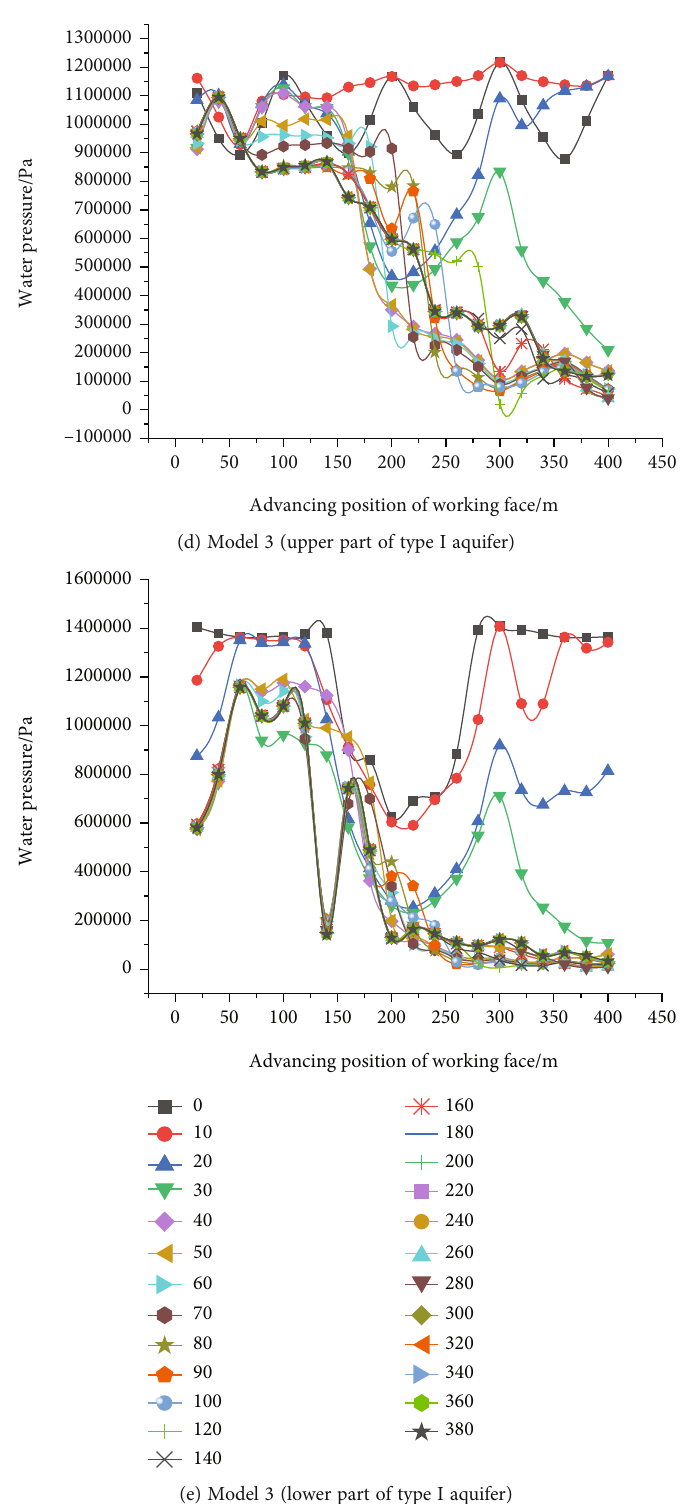
Figure 8: Variation law of water pressure in